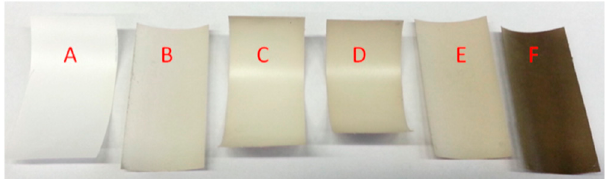
Figure 6. Time dependent polydopamine coating; ( A ) pure membrane, ( B ) 120 min ( C ) 180 min, ( D ) 240 min, ( E ) 300 min, ( F ) 69 h of coating.